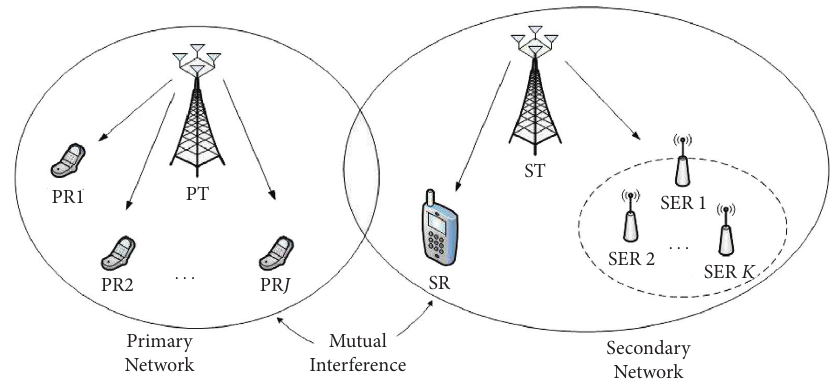
Figure 1: An underlay cognitive radio